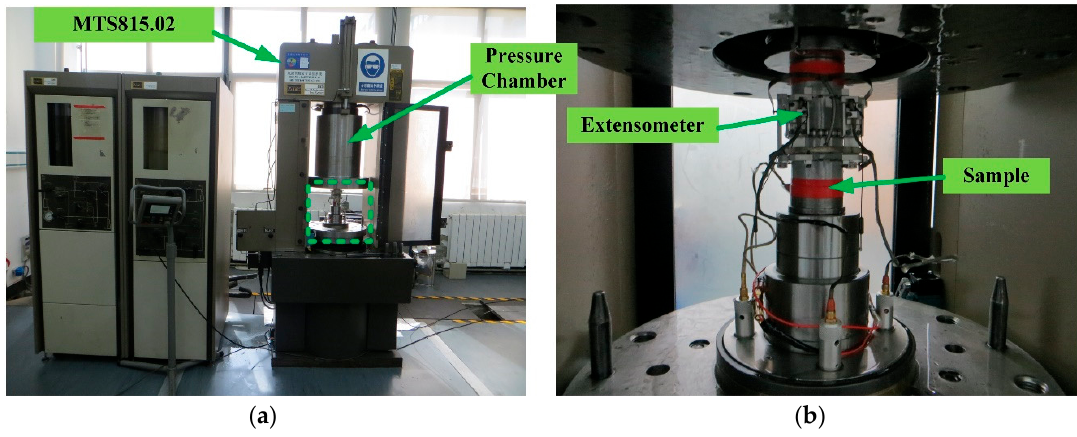
Figure 1. Some AS samples.